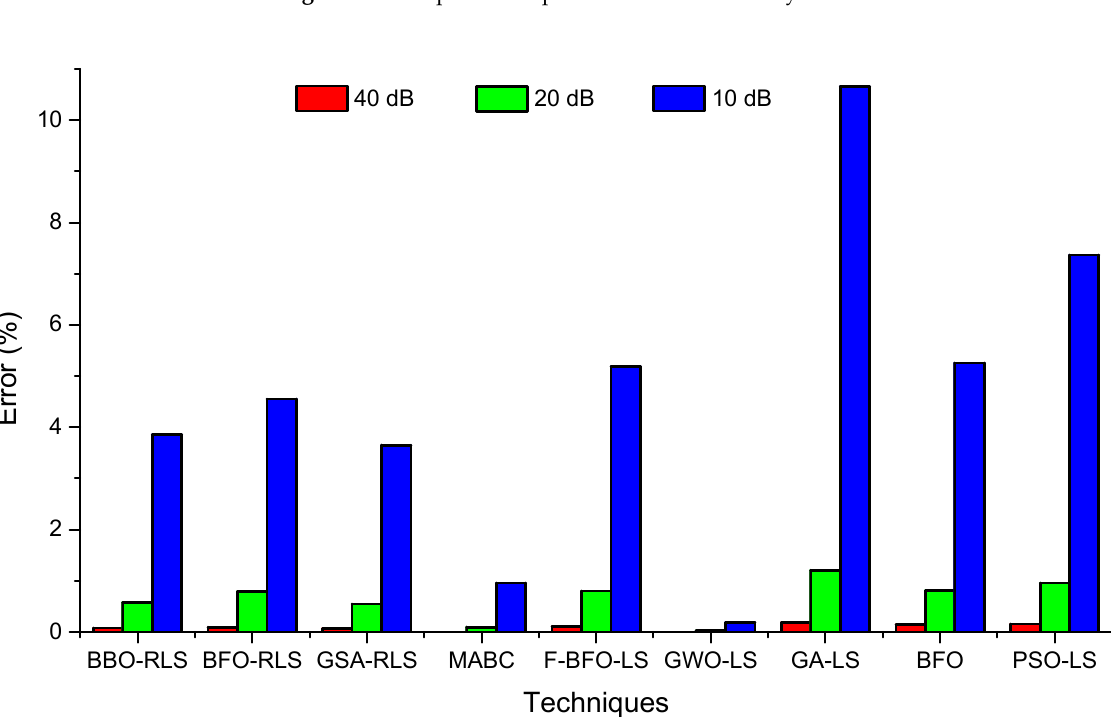
Figure 21. Comparison of performance index for case study II. Table 8. PER comparison of GWO-LS with Literature harmonics estimator for Noisy signals.